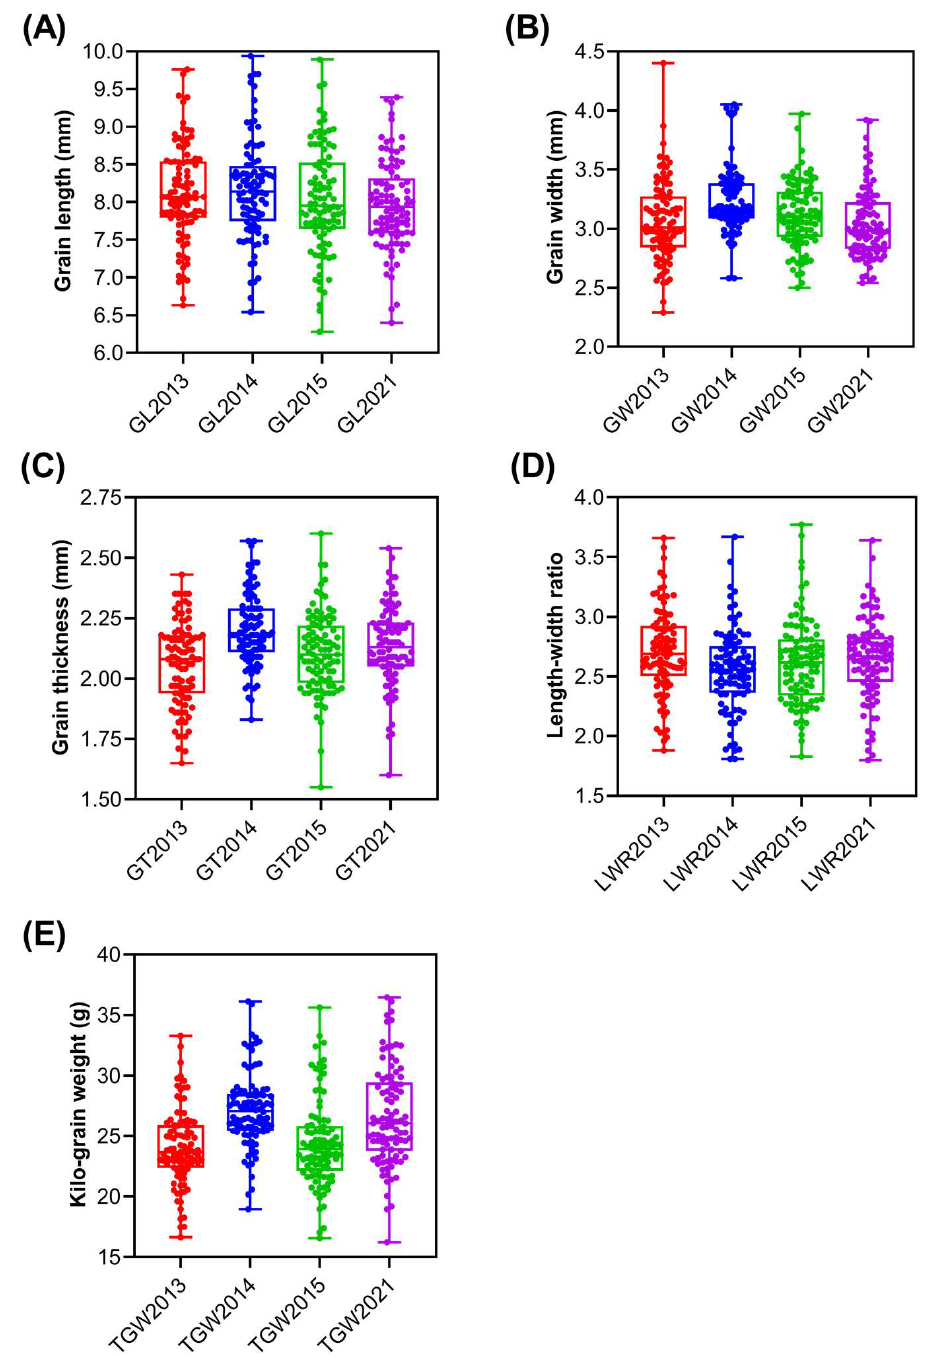
Figure 2. Boxplots ( A – E ) of five grain traits in 2013, 2014, 2015, and 2021.